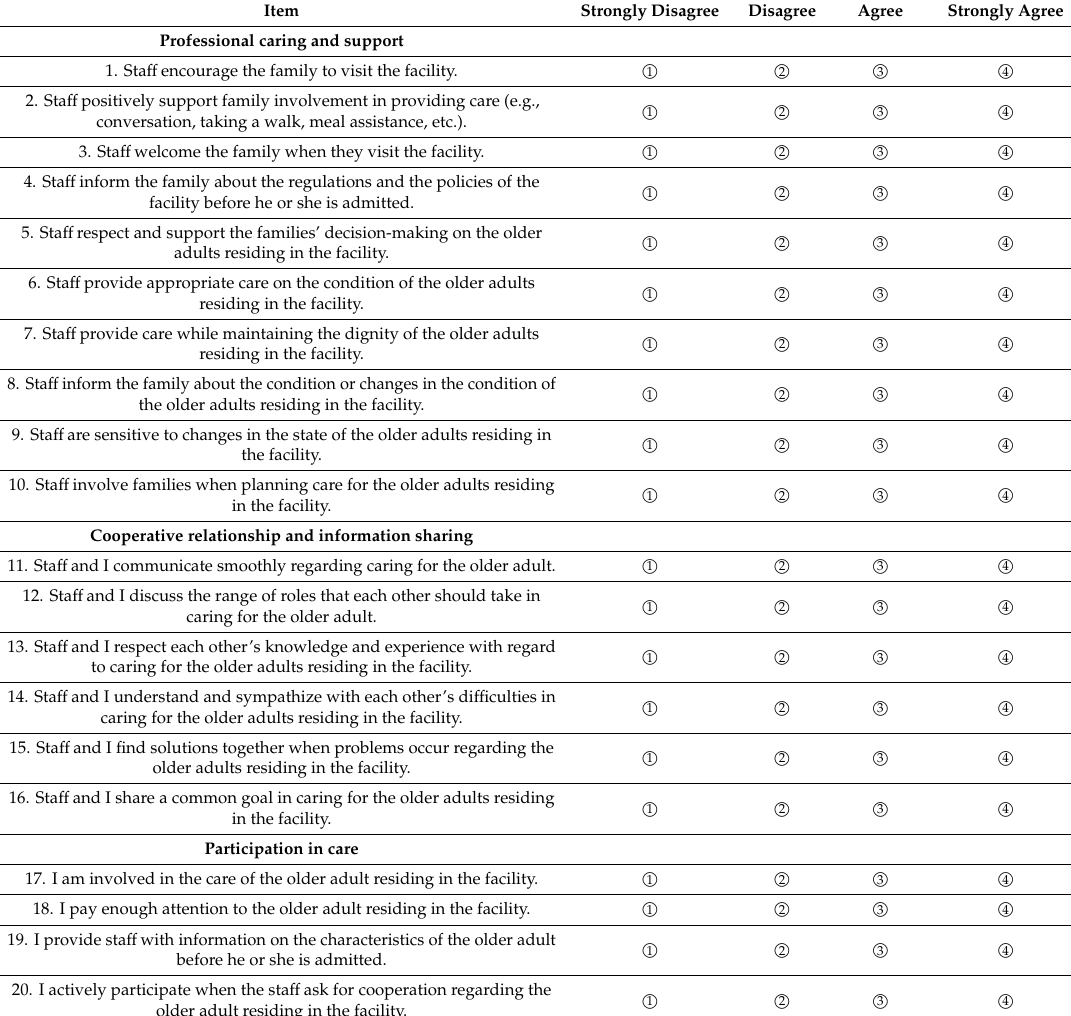
Table A1. The following questions are about partnerships with families and sta ff . For the following questions, please circle the number that best corresponds to your